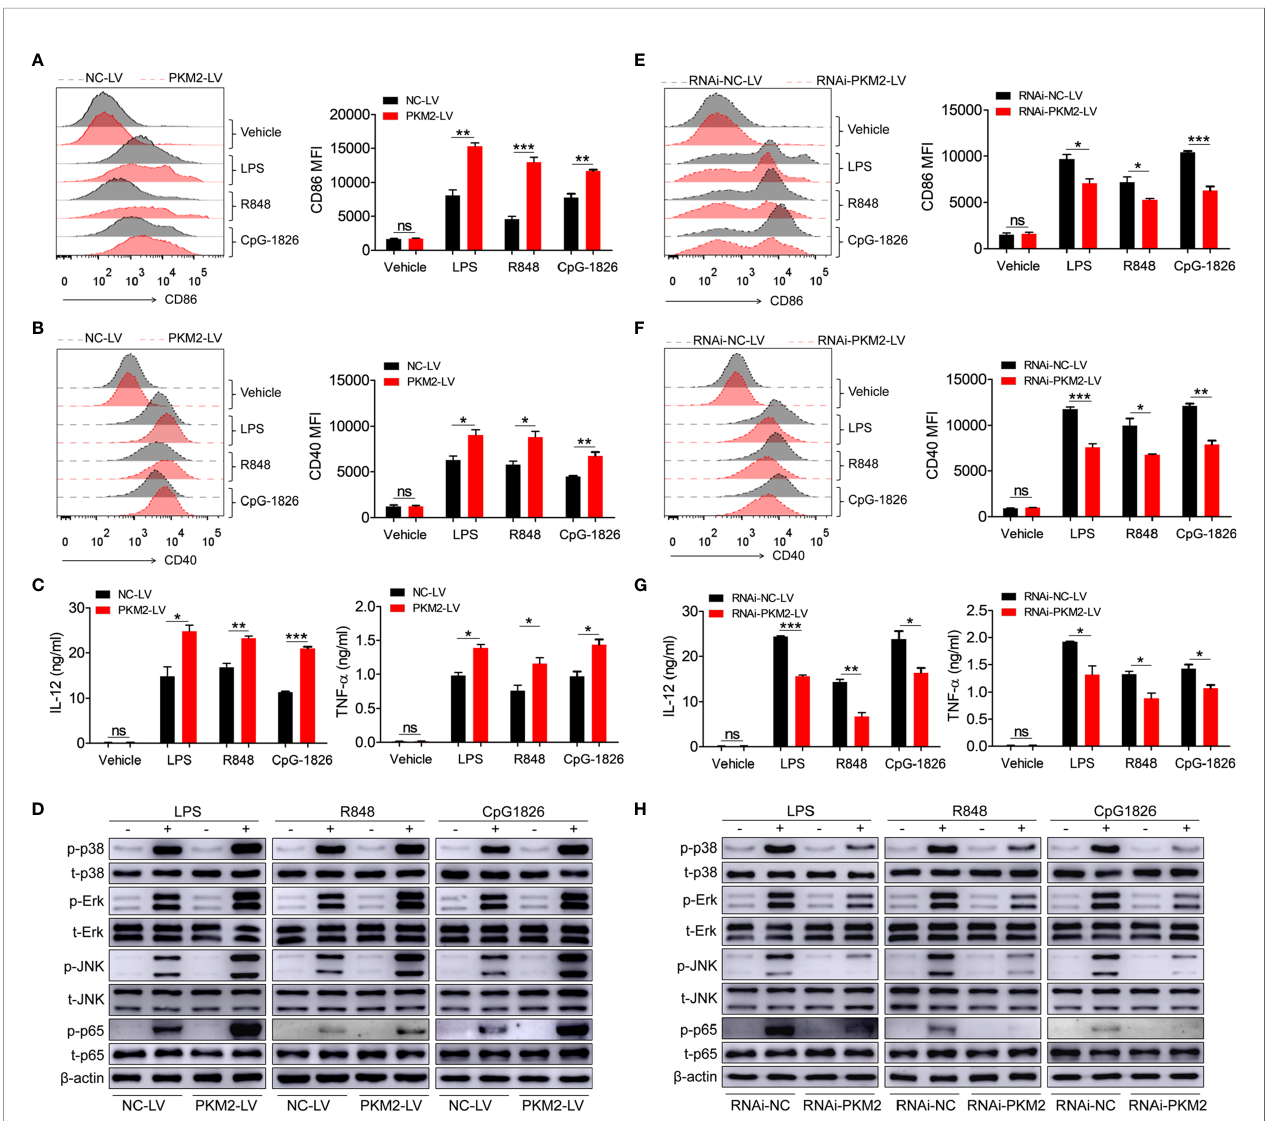
FIGURE 2 | PKM2 augments TLRs-induced activation of BMDMs. (A – D) BMDMs, infected with lentivirus expressing PKM2 (PKM2-LV) or negative control lentivirus (NC-LV) for 3 days, were stimulated by LPS (100 ng/mL), R848 (1 m g/mL) and CpG 1826 (1 m M). FACS analysis of CD86 (A) and CD40 (B) expression at 24 hours. ELISA analysis of the levels of IL-12 and TNF- a secreted by BMDMs at 24 hours (C) . Western blot analysis of the phosphorylation levels of p38, Erk, JNK, and p65 at 1 hour (D) . (E – H) BMDMs, infected with lentivirus expressing negative control-RNAi (RNAi-NC-LV) or PKM2-speci fi c RNAi (RNAi-PKM2-LV) for 3 days, were stimulated by LPS (100 ng/mL), R848 (1 m g/mL) and CpG 1826 (1 m M). FACS analysis of CD86 (E) and CD40 (F) expression at 24 hours. ELISA analysis of the levels of IL-12 and TNF- a secreted by BMDMs at 24 hours (G) . Western blot analysis of the phosphorylation levels of p38, Erk, JNK, and p65 at 1 hour (H) . The data shown represent the means of three independent experiments and the error bars represent the S.E.M. * p < 0.05, ** p < 0.01, *** p < 0.001, as determined by ANOVA tests; ns denotes p >